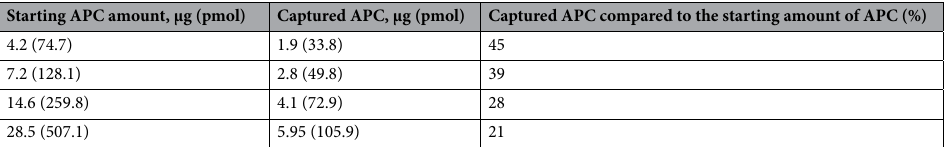
Table 1. Characterization of capturing capacity of HS02-52G-coupled MyOne beads using increasing amounts of APC in binding buffer.